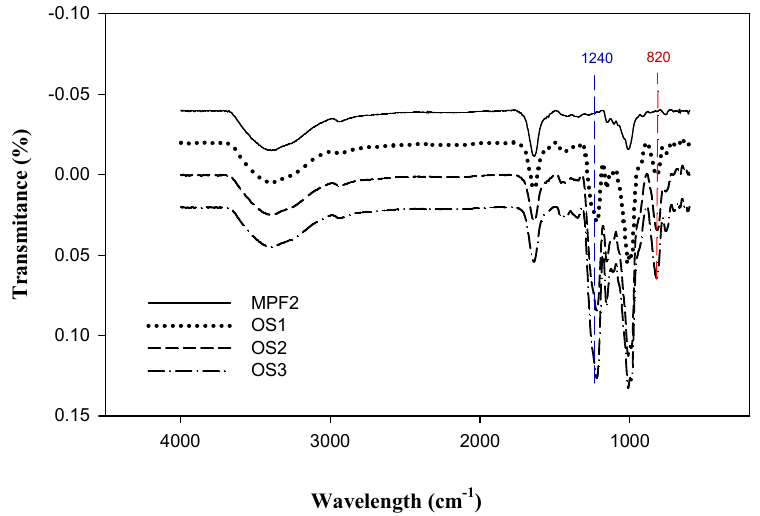
Figure 2. FT-IR spectra of MPF2 and its over-sulphated polysaccharide at 80 °C for 2 h (OS1), 4 h (OS2), and 6 h (OS3).